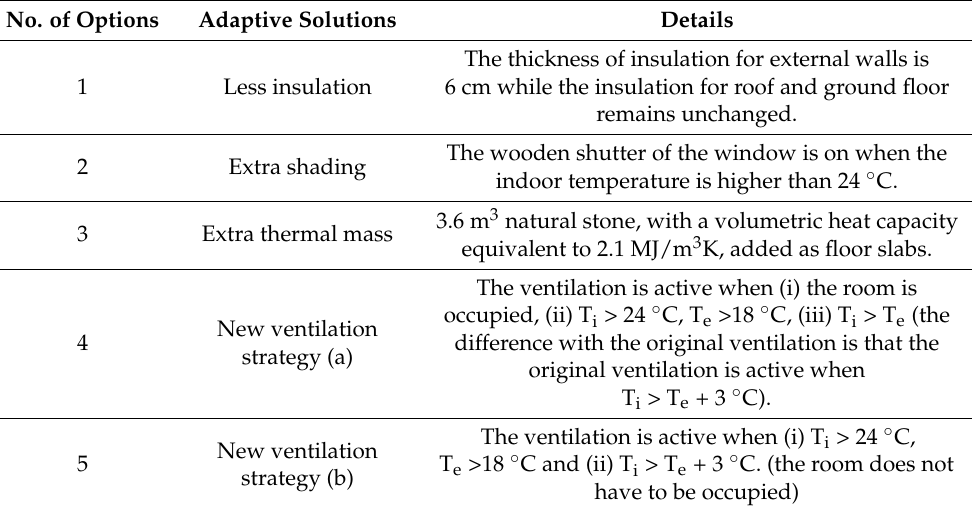
Table 9. Tested adaptation options. T i = Indoor temperature, T e = Outdoor